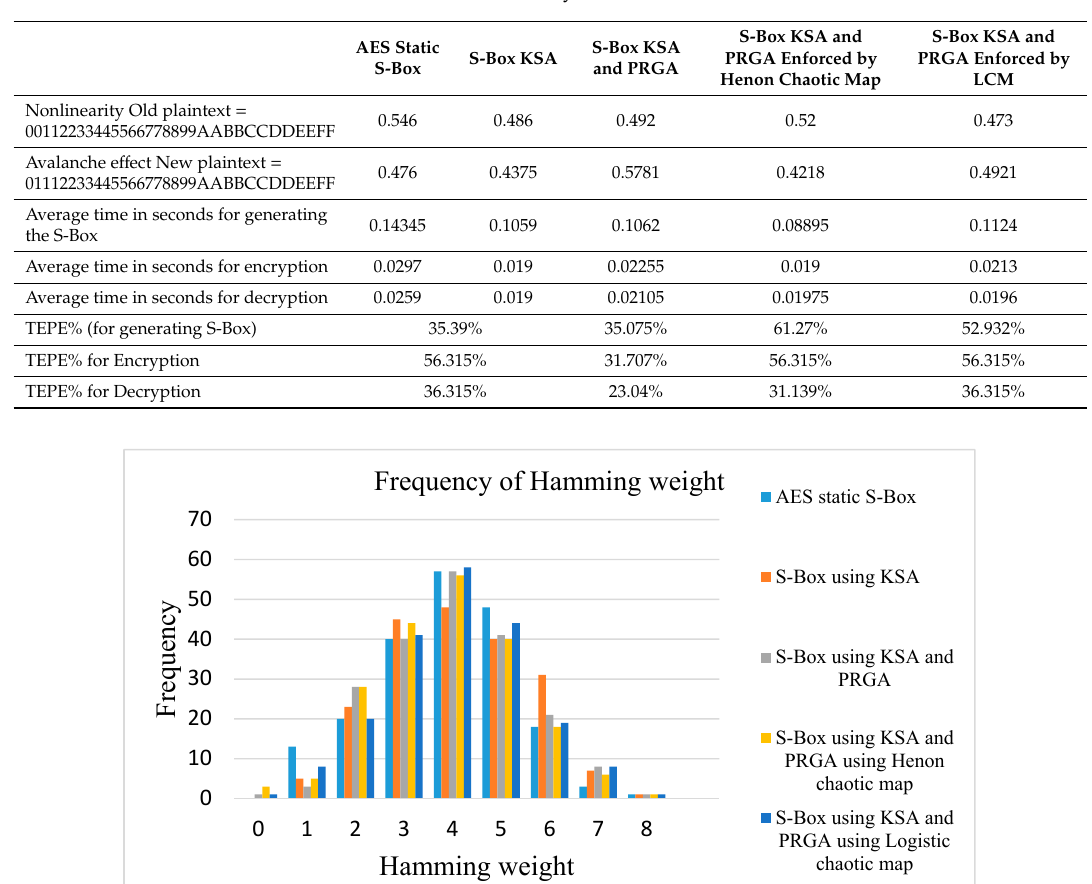
Table 6. Results with the key “0123456789ABCDEF”.